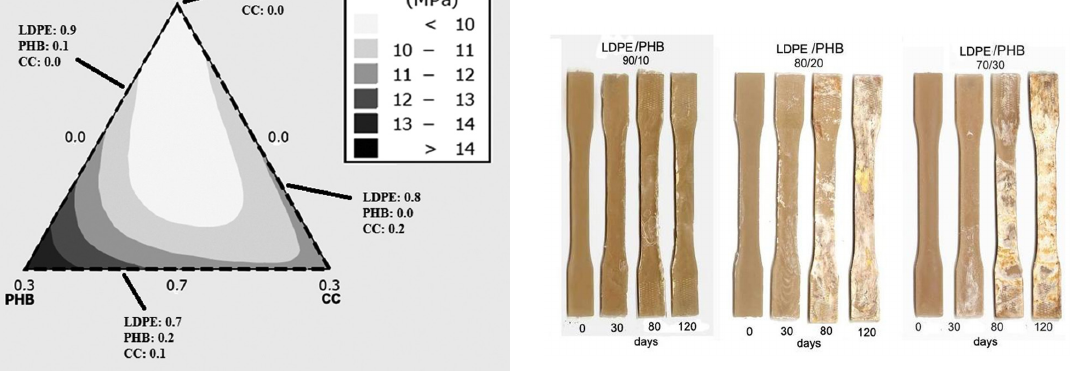
Figure 4. Visual appearance of LDPE/PHB specimens after removal from the soil in different time